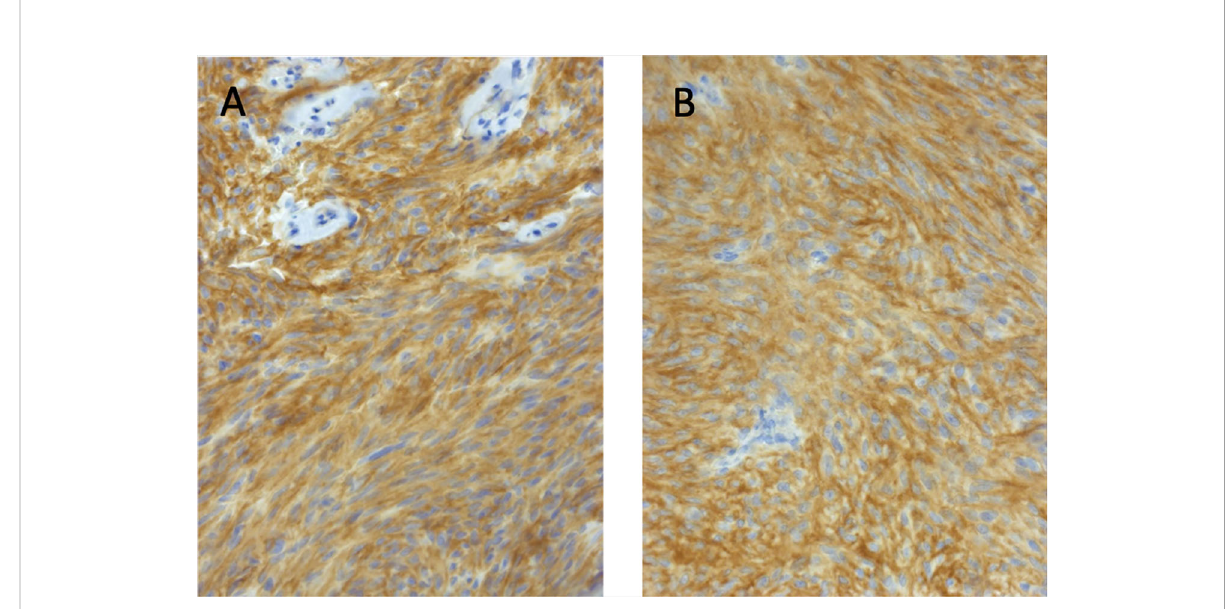
FIGURE 4 Immunohistochemistry did not reveal differences in the expression of somatostatin receptor subtype 2A (SSTR2A) between the right temporopolar (A) and right frontal tumor (B) . Immunohistochemistry with polyclonal rabbit anti-SSTR2A, slide counterstain hematoxylin (1:100 dilution; Zytomed-Systems), original magni fi cation ×400.